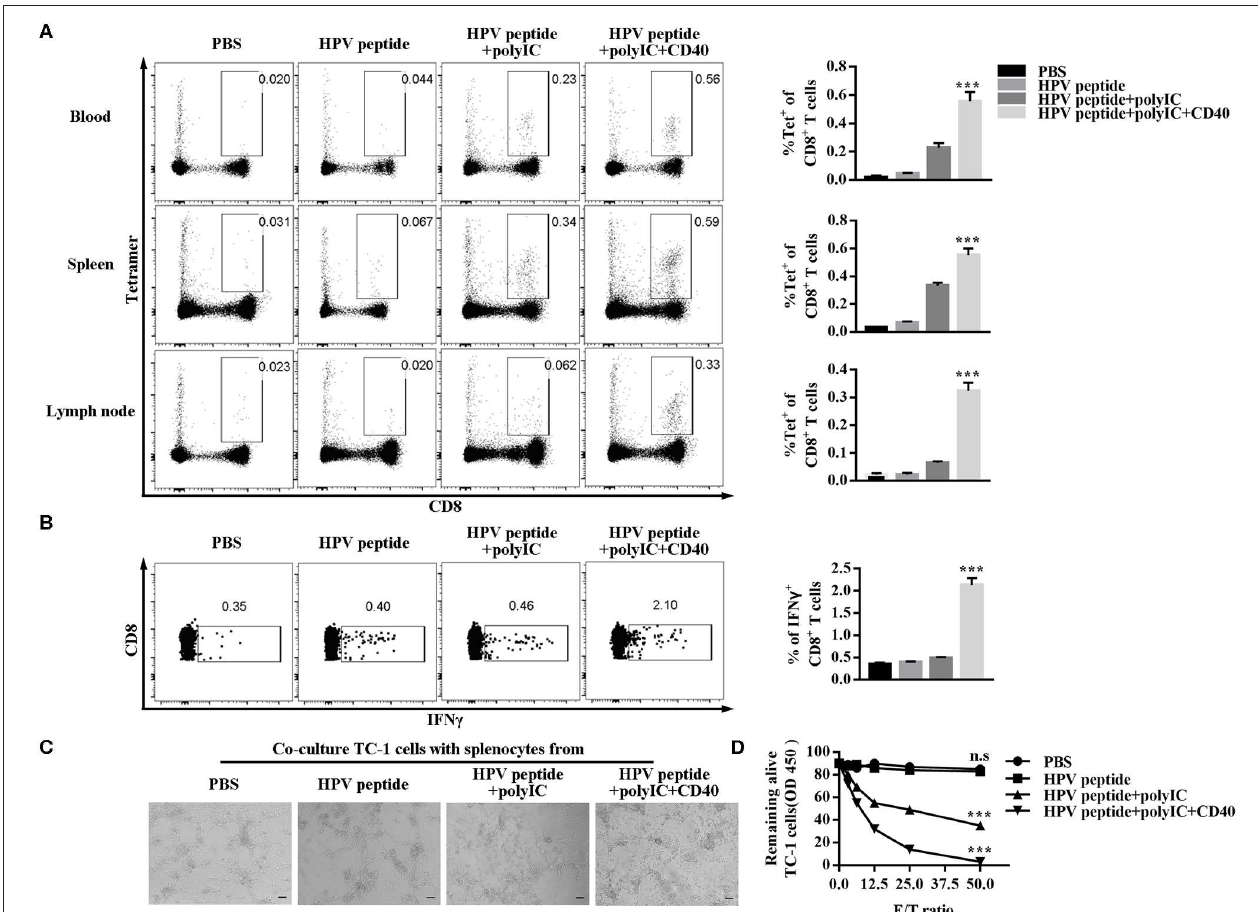
FIGURE 2 | Evaluation of specific CD8 + T cells elicited by immunized mice and ability of killing TC-1 cells in vitro . (A) Frequencies of HPV16-specific CD8 + T cells in blood, spleen and lymph node from each group (3 mice/group) were measured by tetramer analysis 1 months after prime and boost induced by immunization using various vaccine formulations. (B) Splenocytes of the primed and boosted mice ( n = 3 per group) were co-cultured with TC-1 cells for 6h and analyzed for IFN γ in CD8 + T cells. (C) The cytotoxicity of the immunized mouse splenocytes was studied by co-culturing them with TC-1 cells. Pictures were taken after overnight co-culture. Scale bar = 100 µ m. (D) CCK8 assay was then performed to determine the remaining live TC-1 cells after splenocytes were rinsed away. The CCK8 data of TC-1 tumor cells co-cultured with different ratios of splenocytes was compared to CCK8 data of TC-1 tumor cells alone to calculate % of live cells. Shown is the dose-dependent killing of TC-1 cells by splenocytes. Error bars represent the mean ± SD of three independent experiments. *** p < 0.001, n.s, p >